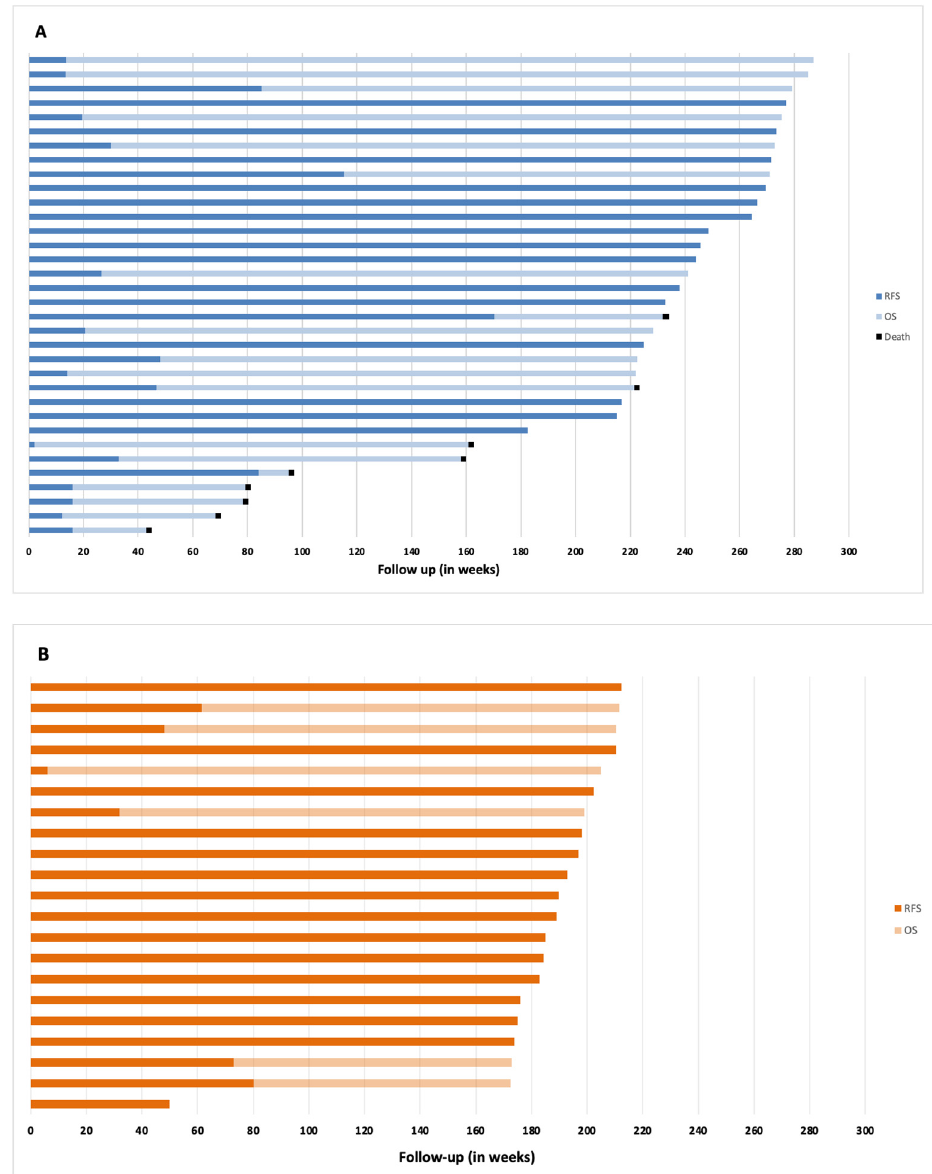
Figure 2. Swimmer plots representing duration of relapse-free survival (RFS) and overall survival (OS) of individual patients in cohort-1 ( A ) and cohort-2 ( B ). Dark blue bars and light blue bars depict RFS and OS, respectively. A black square at the end of a bar depicts death.